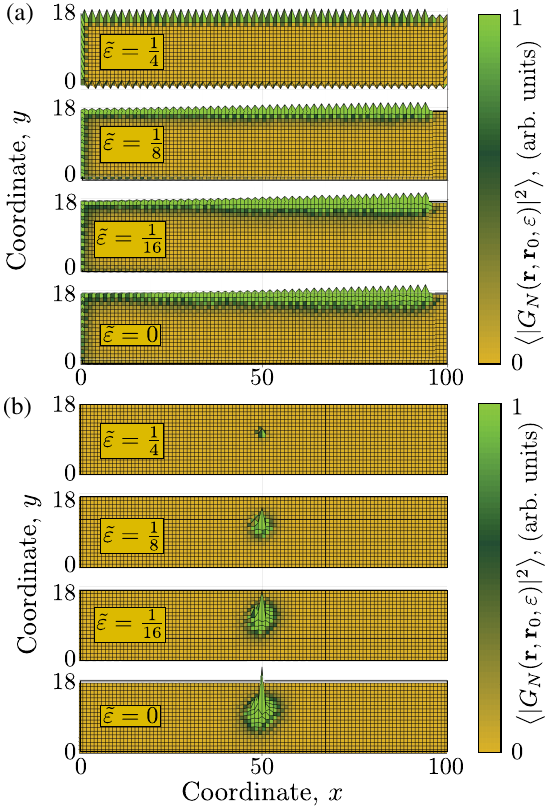
FIG. 5. Wave packet dynamics in the AFAI. Using the same model as in Fig. 4, we plot the amplitude of the transmission probability, hj G N ð r ; r 0 ; ε Þj 2 i , cf. Eq. (18), obtained after a time 300 T and averaged over disorder realizations. evolution of T fin ¼ We simulate a strip of size 20 × 100 with open boundary conditions and plot hj G N j 2 i for several quasienergies, 2 i when the ϵ = Ω ¼ 0 , 1 = 16 , 1 = 8 , 1 = 4 . Panel (a) shows hj G N j initial wave packet is chosen at the edge r 0 ¼ ð 96 ; 18 Þ . It indicates the presence of a robust edge mode at all the given quasienergies. Panel (b) shows the probability when the initial wave packet is chosen in the bulk, r ¼ ð 50 ; 10 Þ . This indicates that the bulk Floquet states are localized. These simulations are carried out with a time step of dt ¼ T= 100